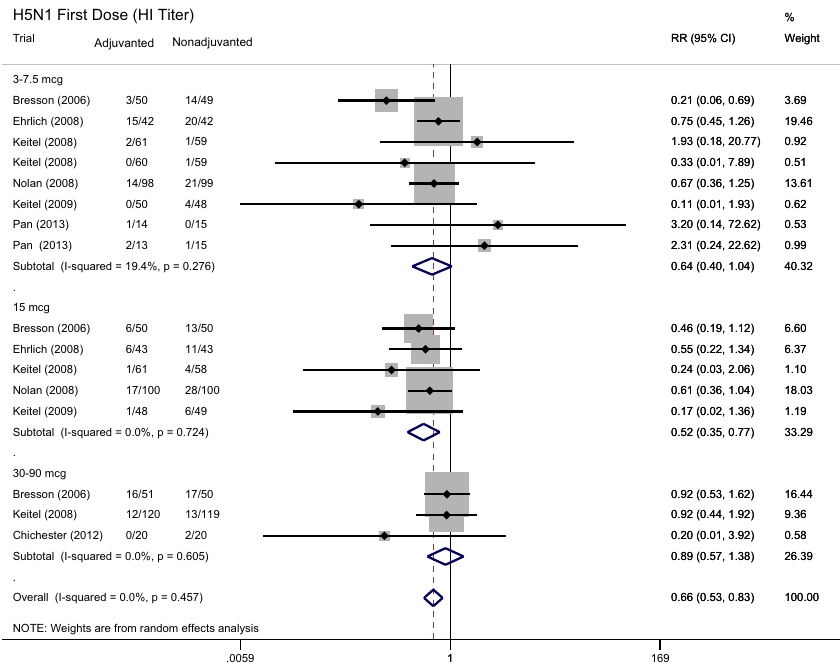
Figure 2. Forest plot showing the ratio of the seroprotection rate by hemagglutinin-inhibition assay, 21–28 days after the first dose of H5N1 vaccines in participants who received aluminum-adjuvanted vaccines versus non- adjuvanted vaccines.